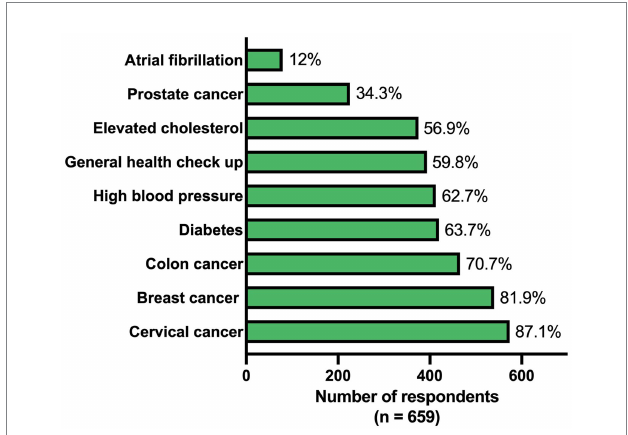
FIGURE 2 Availability of a standardized screening approach for different conditions.